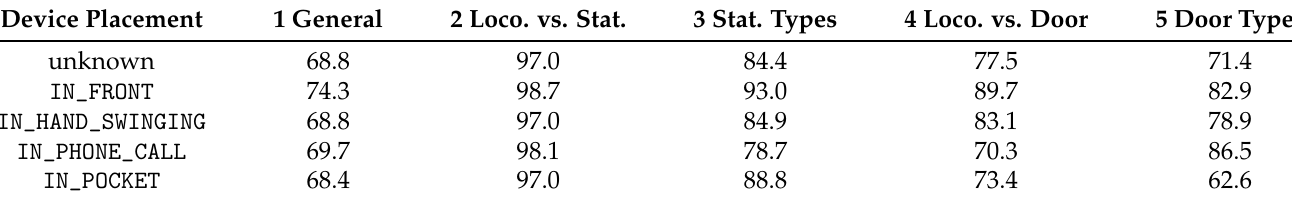
Table 1. Classification accuracy for different configurations and